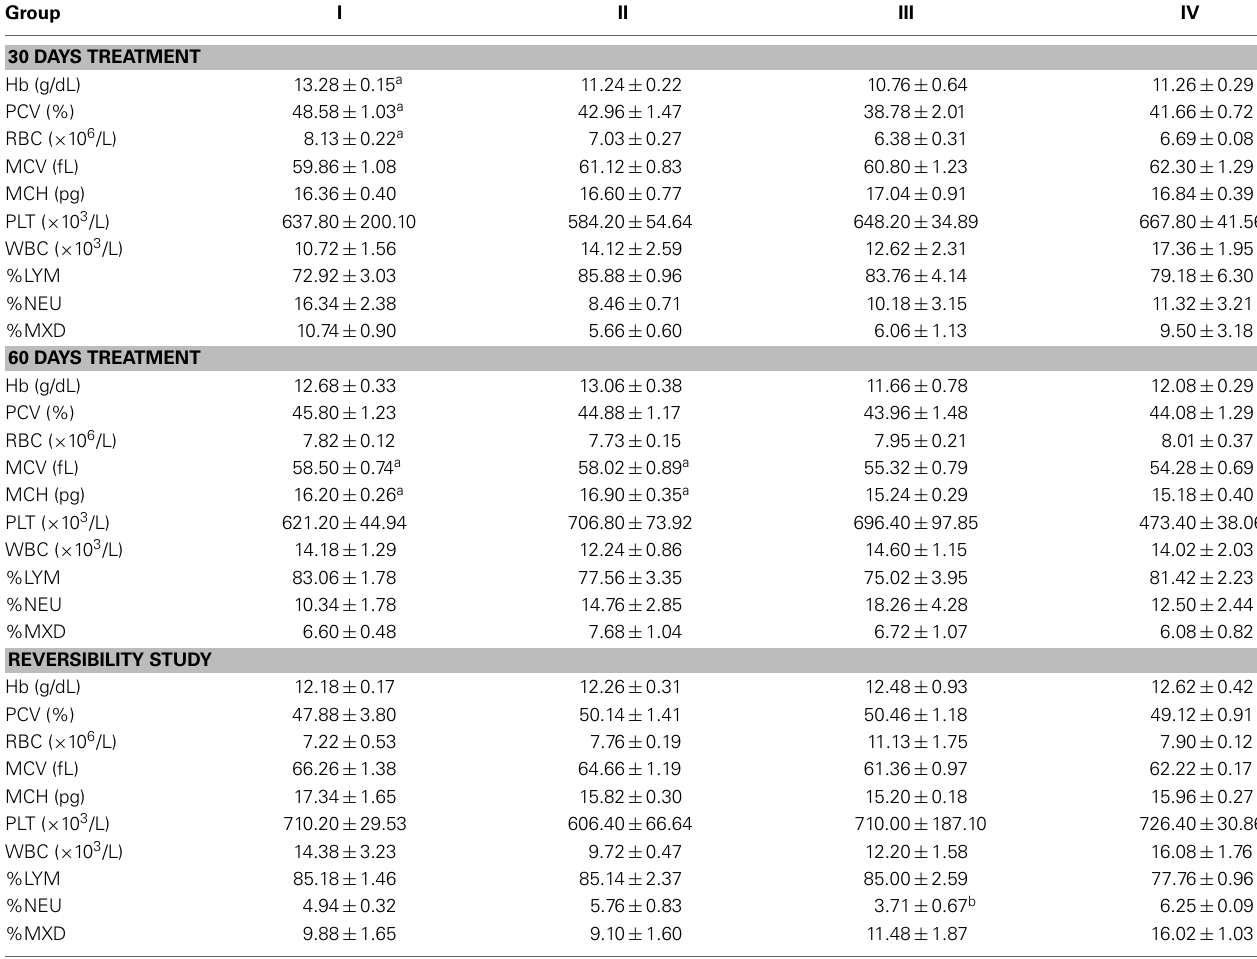
Table 5 | Effect of HLE-FP on hematological parameters in the sub-chronic oral toxicity study. Group I